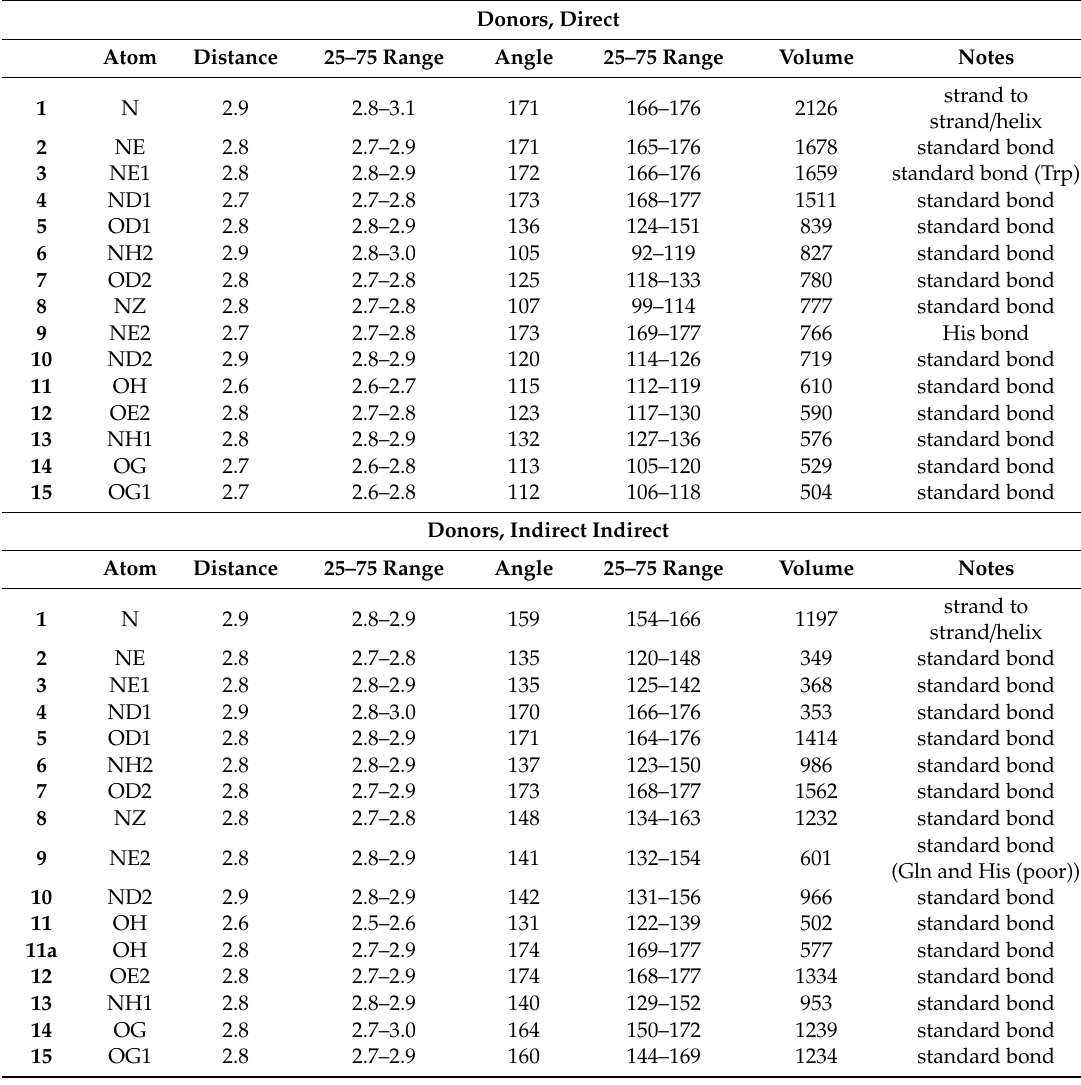
Table 1. Table of identified and confirmed HMI. The confirmed HMIs are listed according to donor or acceptor heavy atom identity with geometries given using either the direct or indirect angles. Atom types are listed in order of decreasing cluster volume (for the direct angle) and the average (by center of mass) distance and angle and the 1st and 3rd quartiles (25–75 range) are also given, as well as general information about the